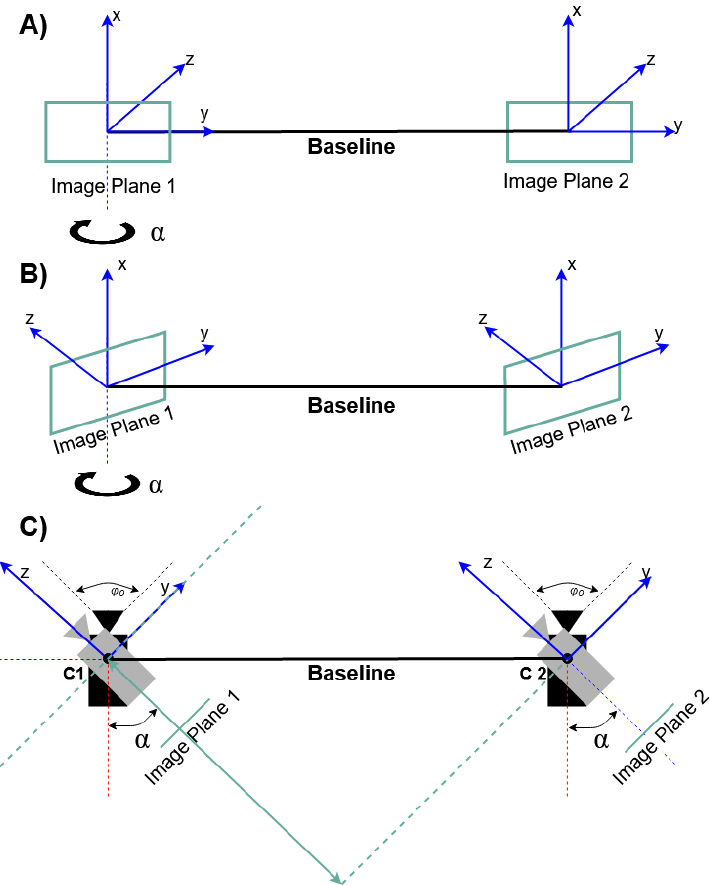
Figure 2. Stereovision model: ( a ) classical; ( b ) with rotated image planes; ( c ) illustration of the cameras’ alignment for the modified stereovision. Table 2. Definition of the basic variables and parameters of the mathematical model along with units used.